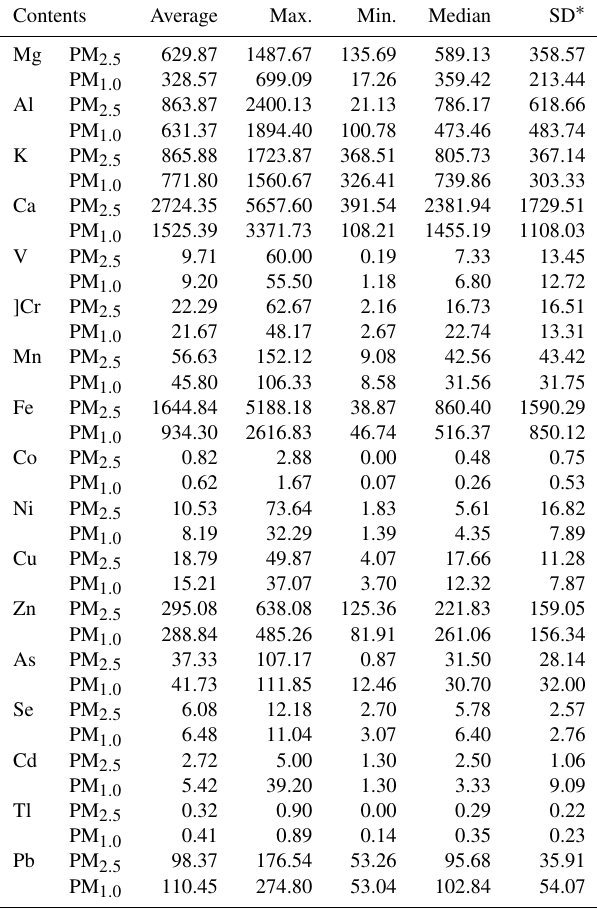
Table 3. The average concentration of the elements in PM 2 . 5 and PM 1 . 0 (ngm − 3 ) during the